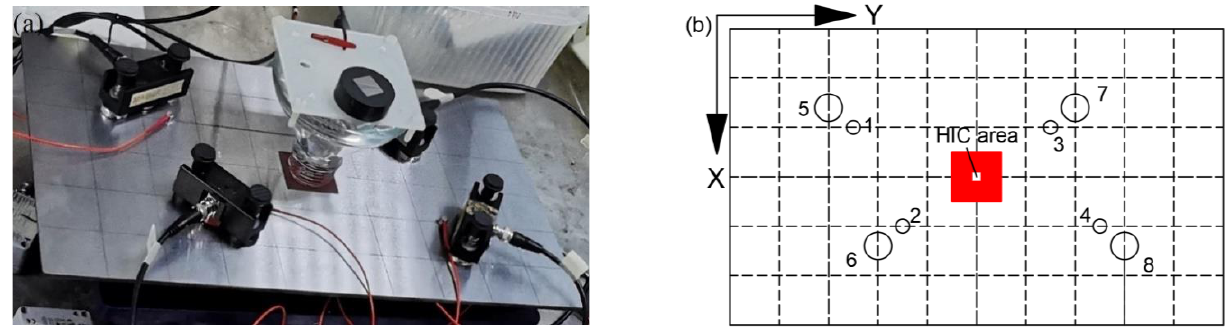
Figure 3. Test 4 ( a ) physical setup; ( b ) locations of sensors. Small circles represent Nano30 sensors and big circles represent VS150-RIC sensors . Table 3. Details of sensors for Test 4